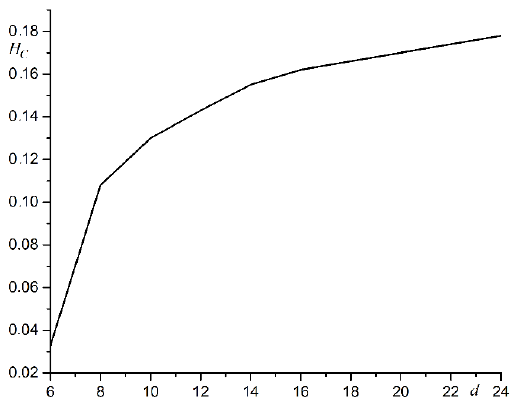
Figure 7. Dependence of coercive force H C on antidote lattice period d . Coercive force grows nonlinearly with increasing antidote lattice period. The coer- cive force value tends to a limit value for a solid thin film as the period of the antidote lattice grows.